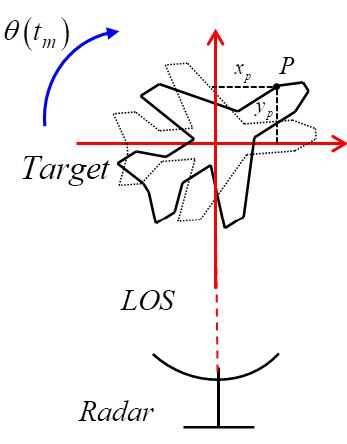
Figure 1. Turntable model of ISAR imaging.